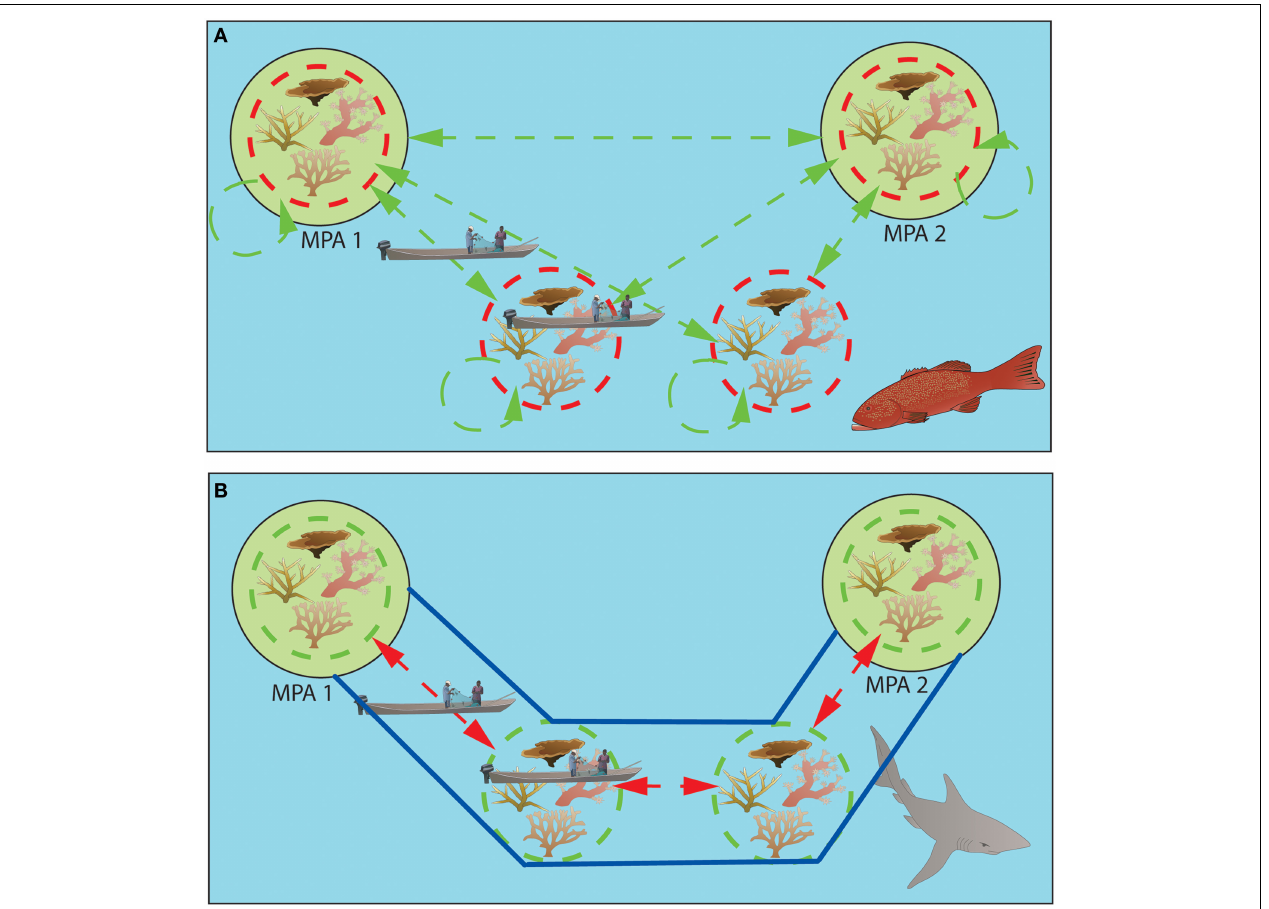
FIGURE 1 | Consequences of different life history strategies on the effectiveness of networks of MPAs. (A) larval dispersal, sedentary adults. Adult home range is shown in red dashed circles, larval dispersal in dashed green lines. Adults are effectively protected by MPAs (shown in green), and connectivity is ensured via larval dispersal, while a portion of the larvae settles within natal reefs. MPAs also provide recruitment subsidies to fished reefs. (B) Adult